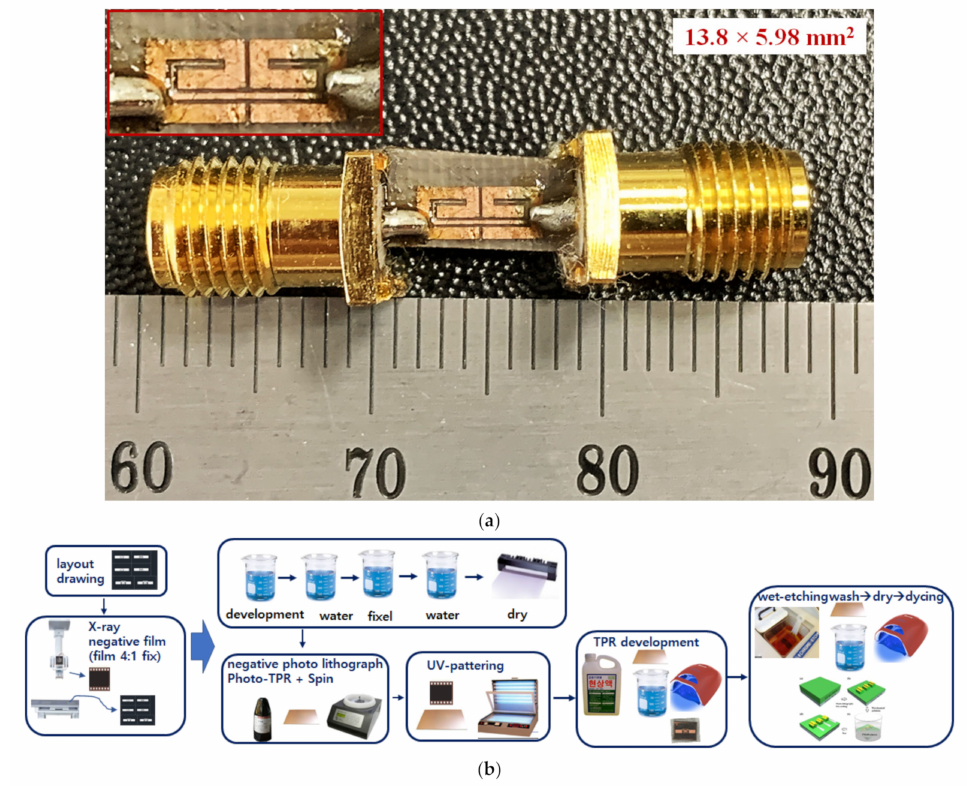
Figure 6. Fabrication of a new bandpass filter: ( a ) photograph and ( b ) fabrication process (wet